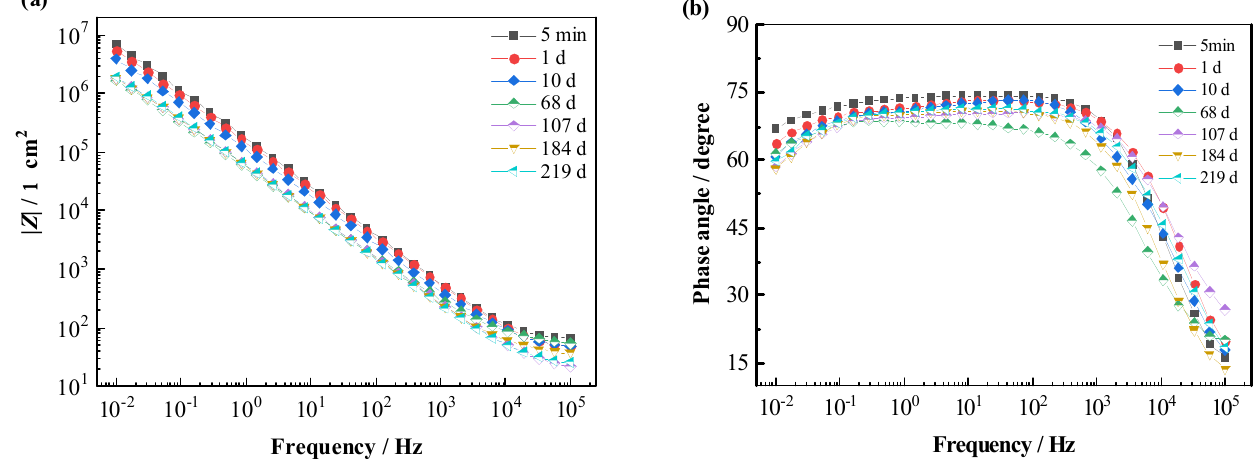
Figure 8. EIS Bode spectra of T700/BMI composite in 3.5% NaCl solution. ( a ) Impedance modulus; ( b ) Phase angle. ( b ) Phase